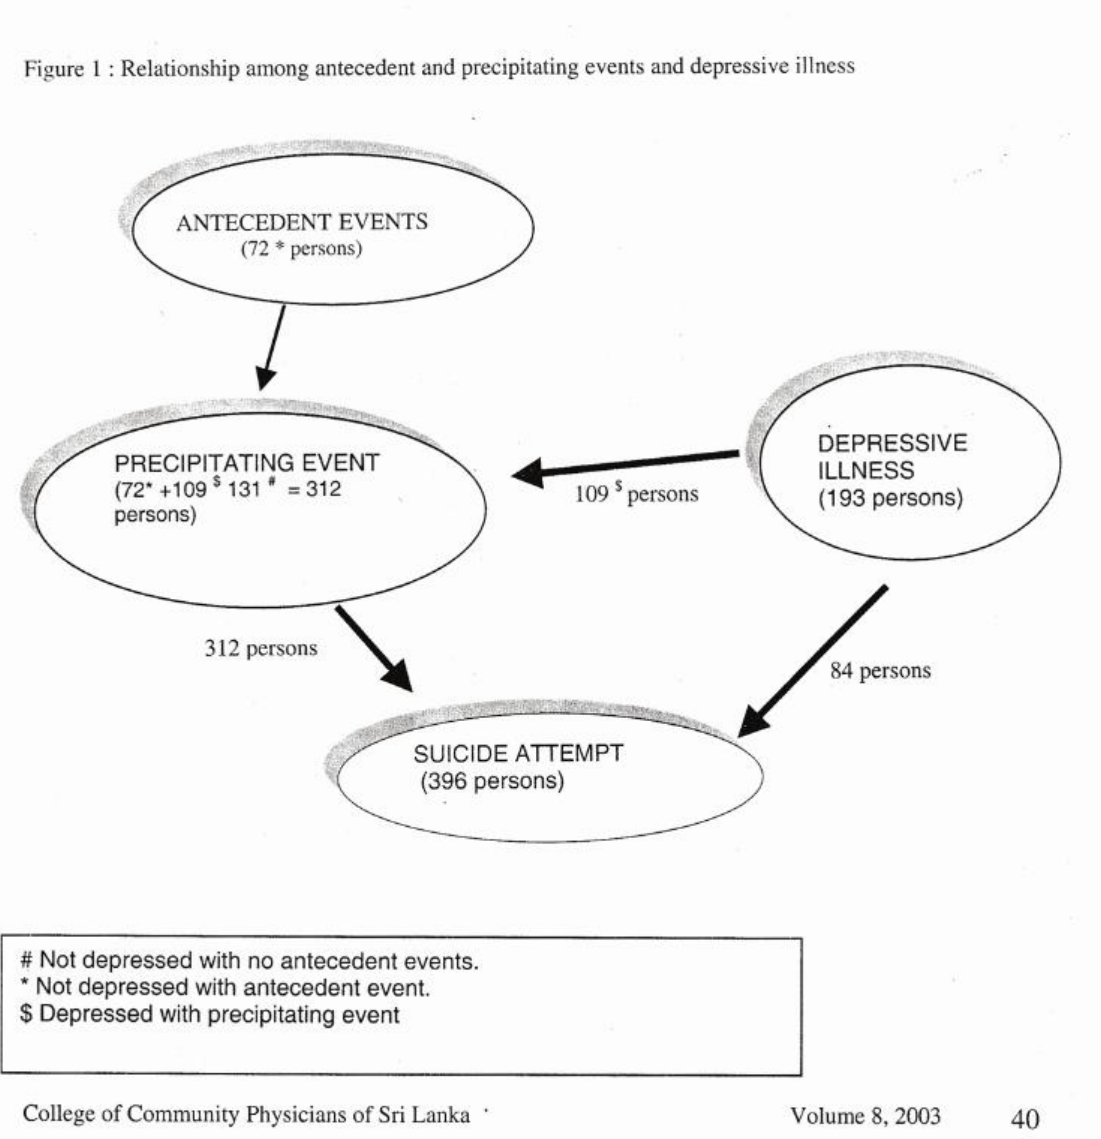
Figure I : Relationship among antecedent and preci